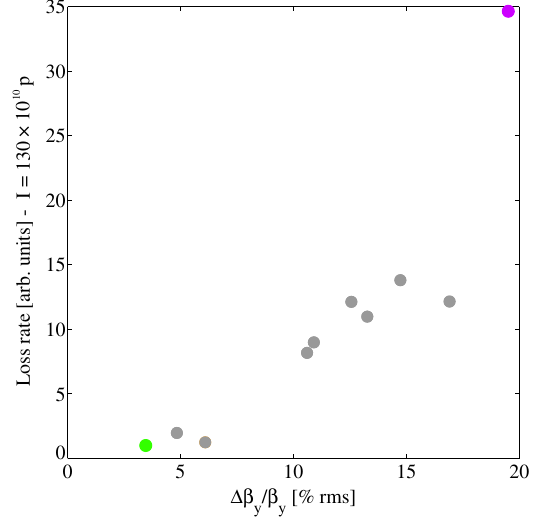
FIG. 10. Loss rate vs vertical beta beating at 130 × 10 10 p for the different loss profiles. The curves are normalized with respect to the slowest loss rate. Colored points are the values of the loss rate for two different beta-beating seeds as shown in Fig. 9. The gray points are all the other simulated seeds.